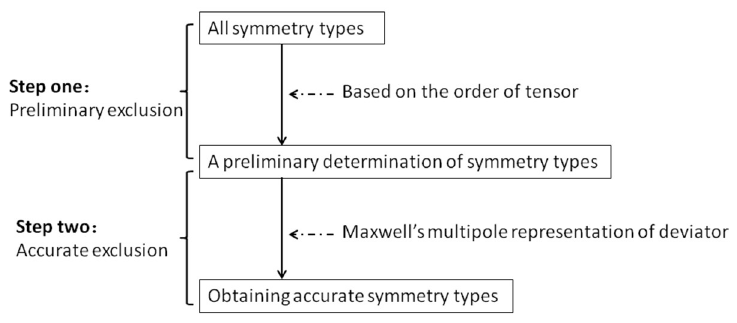
Figure 1. The method route of symmetry classification.